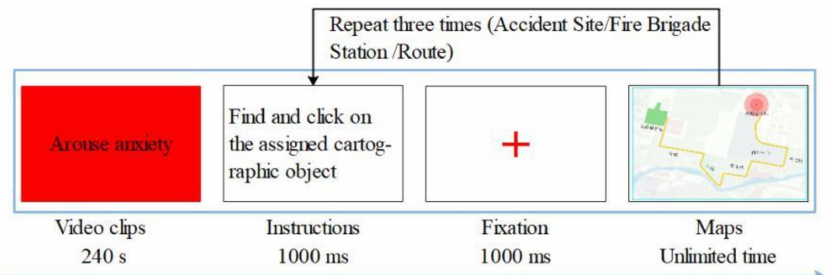
Figure 6. Experimental process of crisis map reaction time